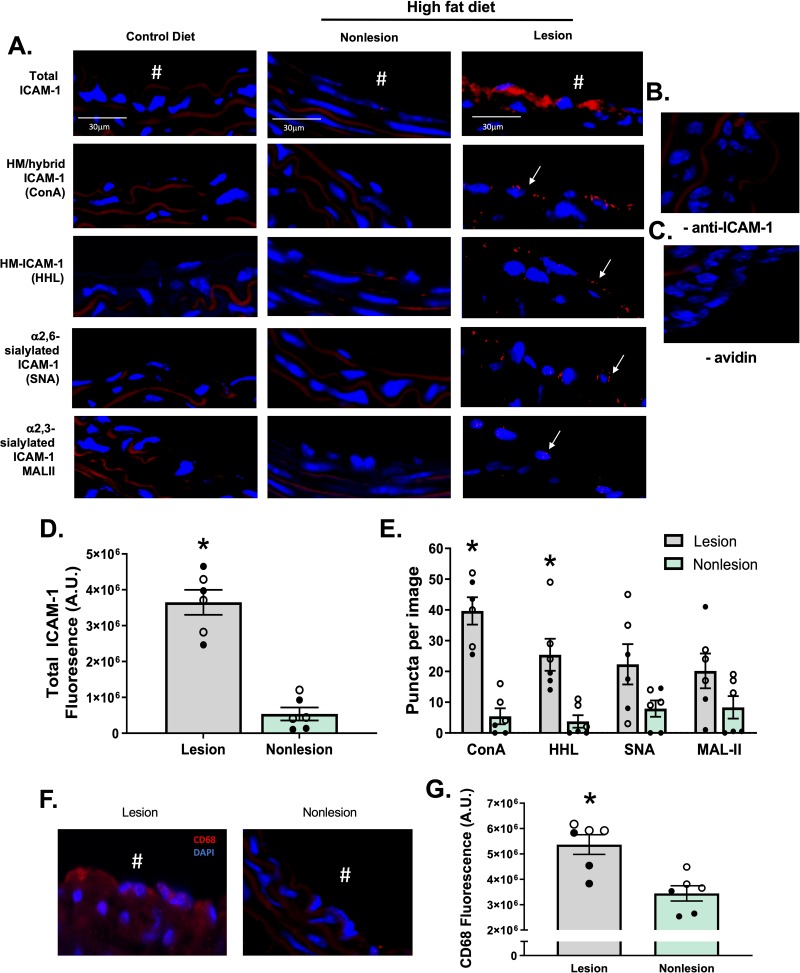
HM epitopes co-localize with ICAM-1 in high fat-induced mouse atherosclerosis.Total, HM / hybrid, α-2,6-sialylated, and α-2,3-sialylated ICAM-1 were measured in the innominate and left carotid arteries from ApoE-/- mice fed a normal or high fat diet. A) Shown are representative images of innominate arteries from paired lesion and non-lesion areas of the same vessel section. Red staining represents total ICAM-1, red puncta represent positive PLA staining for specific ICAM-1 N-glycoforms (indicated by arrows), and blue staining represents DAPI. # indicates the lumen of each vessel. Panels B and C show PLA staining of lesion areas when the anti-ICAM-1 antibody or avidin were excluded. Panel D shows total ICAM-1 staining in lesion versus non-lesion areas. *p<0.05 by t-test. Panel E shows number of puncta for HM / hybrid, HM, α-2,6-sialylated, and α-2,3-sialylated ICAM-1 in lesion versus non-lesion areas. Data are mean ± SEM, each symbol represents a distinct mouse, n = 6. *p<0.05 compared to non-lesion via paired t-test. F. Representative images of CD68 staining (red) in lesion vs. non-lesion areas. G. Quantitation of CD68 staining in lesion and non-lesion areas. Data are mean ± SEM, each symbol represents a distinct mouse, n = 6. * = p<0.05 compared to non-lesion via paired t-test. ● from innominate arteries and ○ from left carotid arteries.